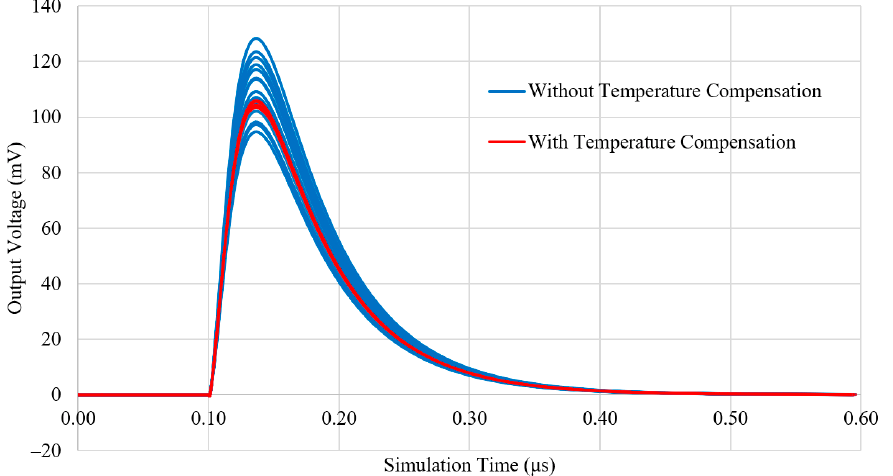
Figure 5. LTspice simulation of an amplified pulse from the two systems over the temperature range of − 20 to 50 °C with a step of 5 °C. Traces of blue and red correspond to the non-compensated and Zener compensated systems, respectively.